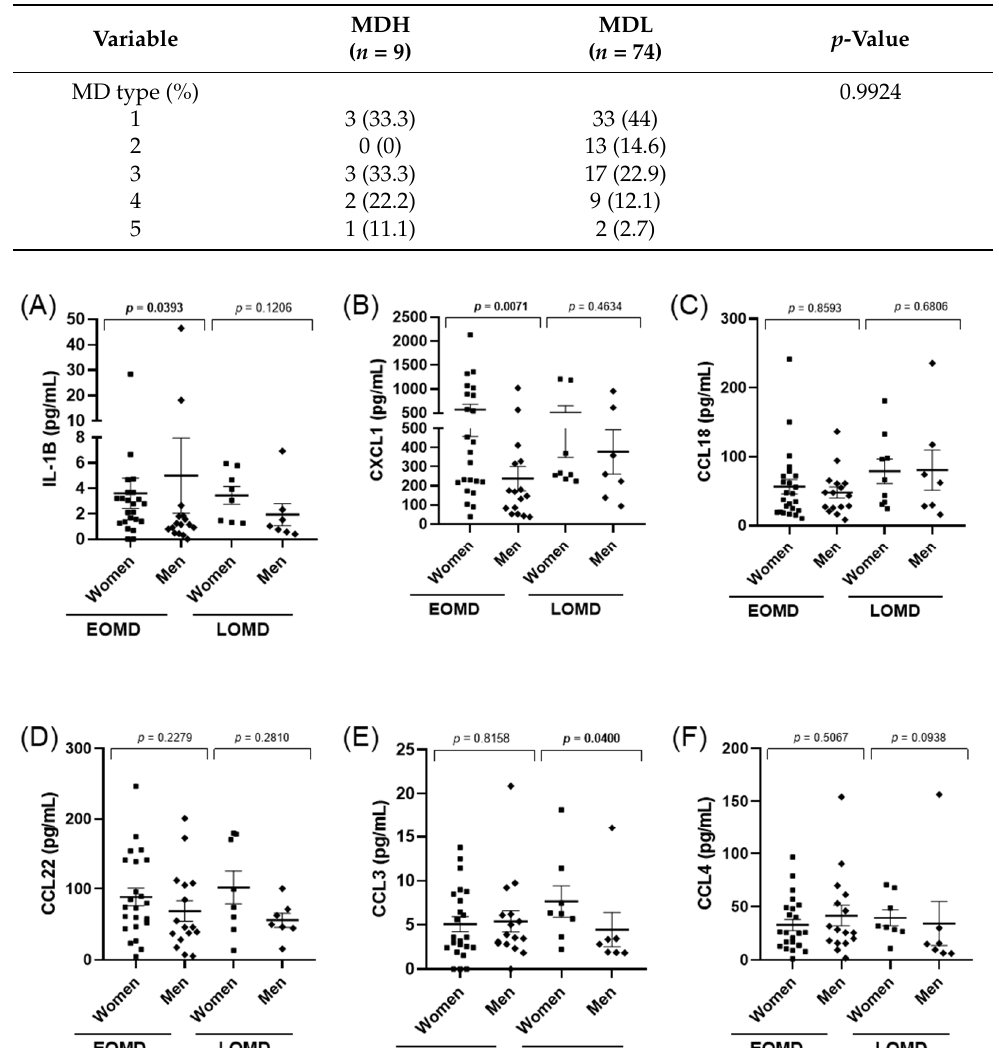
Table 5. Frequency distribution of patients with MD according to the clinical subgroup and IL- 1 β levels.